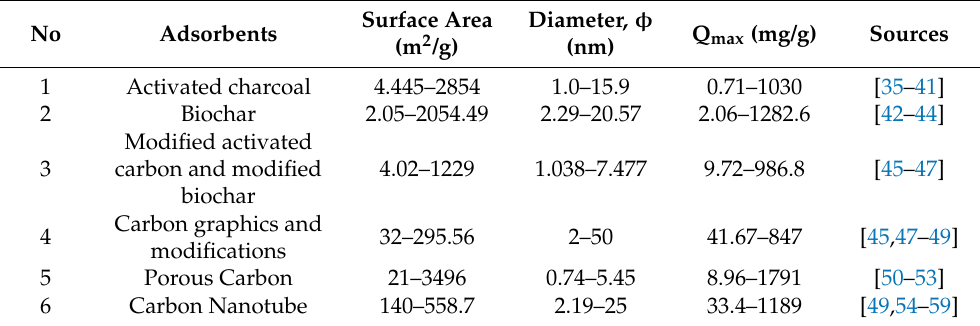
Table 1. Structural characteristics and adsorption capacity of adsorbent in relation to the efficiency of the elimination of MB within the 2008 to 2020 period.